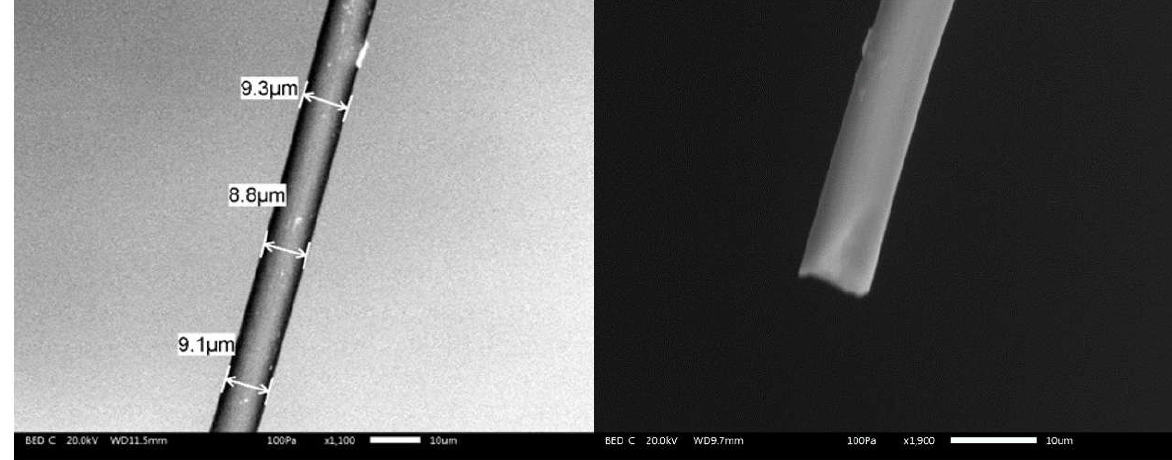
Figure 1. Typical SEM images of two carbon fibers used in this study (JSM-IT300 SEM).